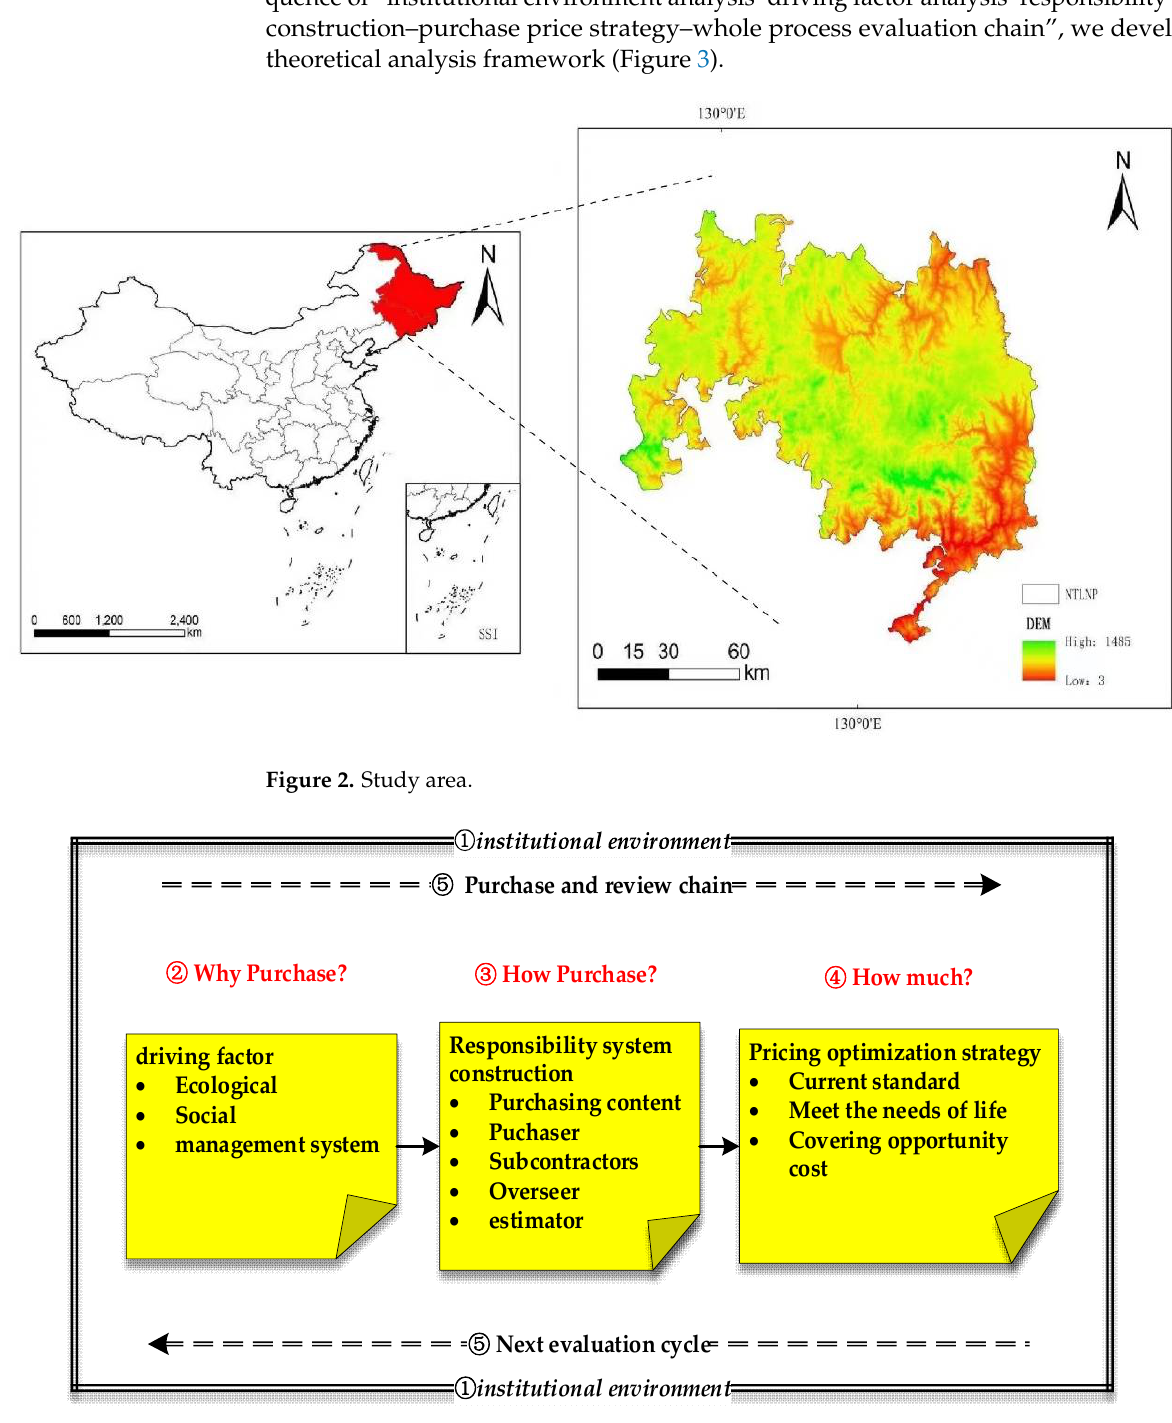
Figure 3. Theoretical analysis framework.